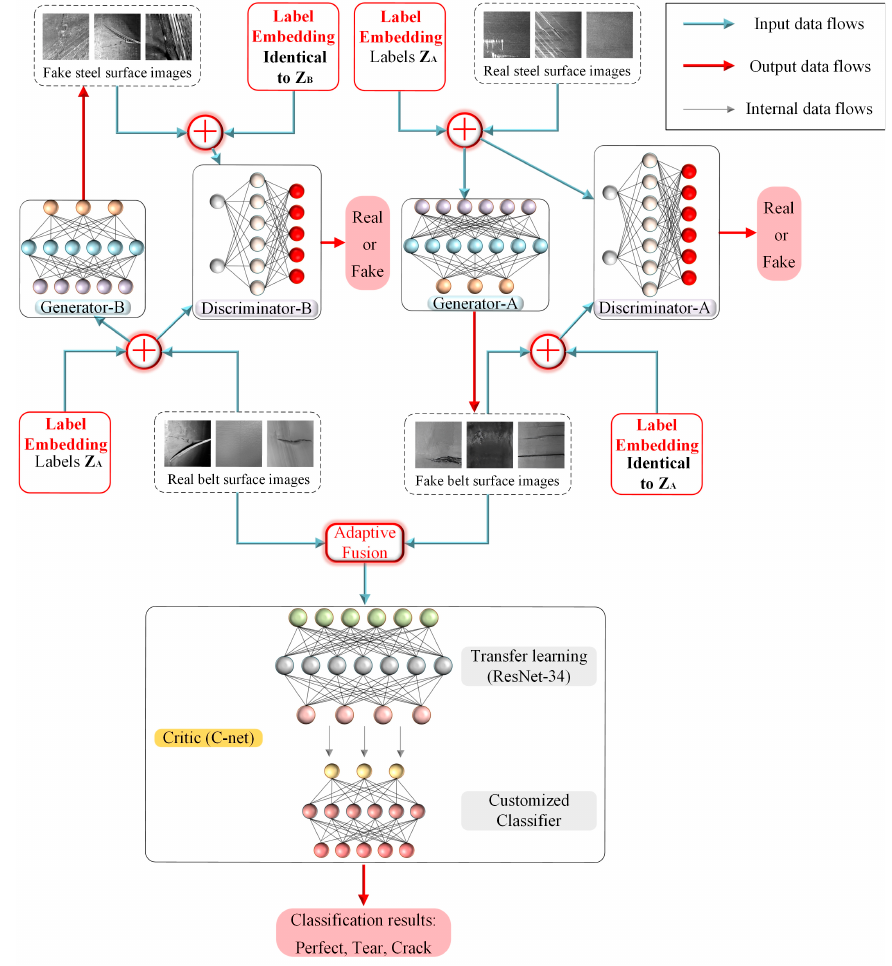
Figure 1. The topology of the proposed MCC-CycleGAN. The G-net transfers real steel surface im- ages into fake belt surface images, which are fused with real belt surface images. The merged im- ages, as new training samples, are fed into C-net.